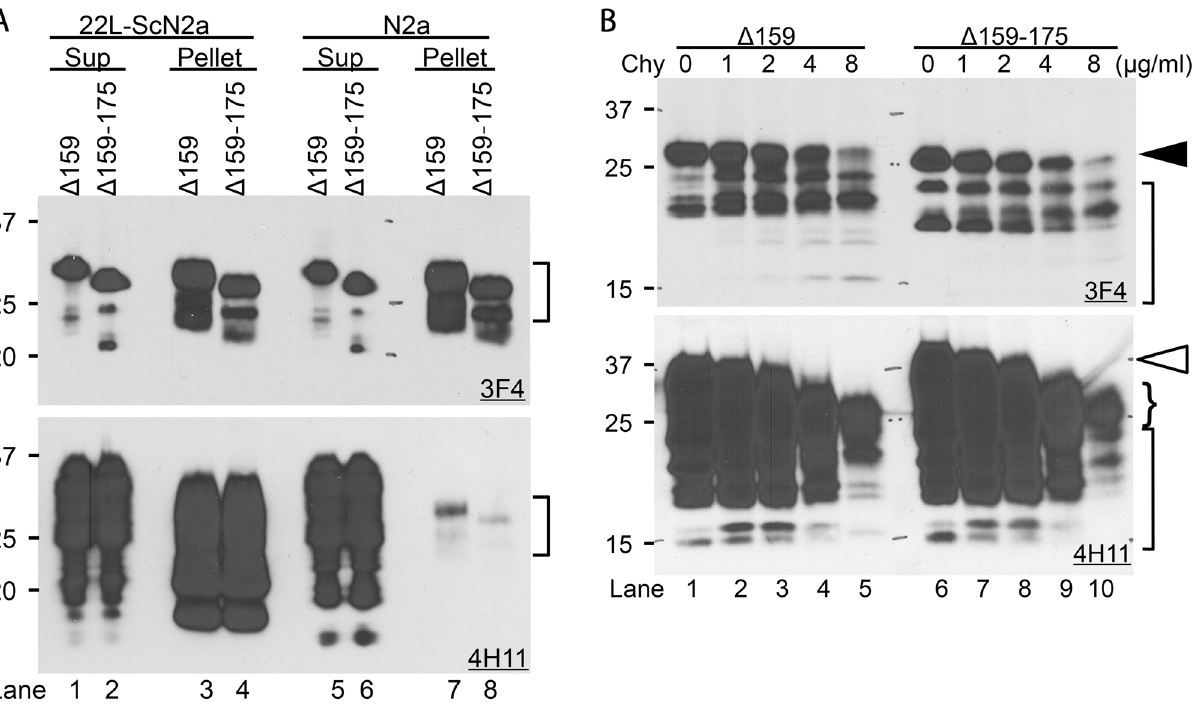
Figure 3. D PrPs spontaneously form aggregates that are detergent-insoluble and relatively chymotrypsin-resistant. A. D PrPs are insoluble in detergent solution. Immunoblots showing partition of D 159 and D 159–175 in supernatant (Sup) and pellet fraction after ultracentrifugation of lysates supplemented with 4% sarcosyl. Upper panel is mAb 3F4, lower panel is membrane re-probed with mAb 4H11 detecting also endogenous wild-type PrP besides D PrPs. The majority of D PrPs is found in the insoluble fraction in both infected and non–infected cells (upper panel, lanes 3, 4, 7 and 8). Wild-type PrP almost completely partitions into the soluble fraction (Sup) in non-infected N2a cells with present conditions. PrP in pellet fractions of non-infected N2a cells is from D PrPs as can be seen from the banding pattern (Lane 7 and 8, square bracket). PrP in lanes 3 and 4 (lower panel) is PrP27-30. B. D PrPs are moderately resistant to chymotrypsin digestion. Immunoblots showing chymotrypsin-resistant fragments of D 159 and D 159–175 from transiently transfected N2a cell lysates digested with indicated concentrations